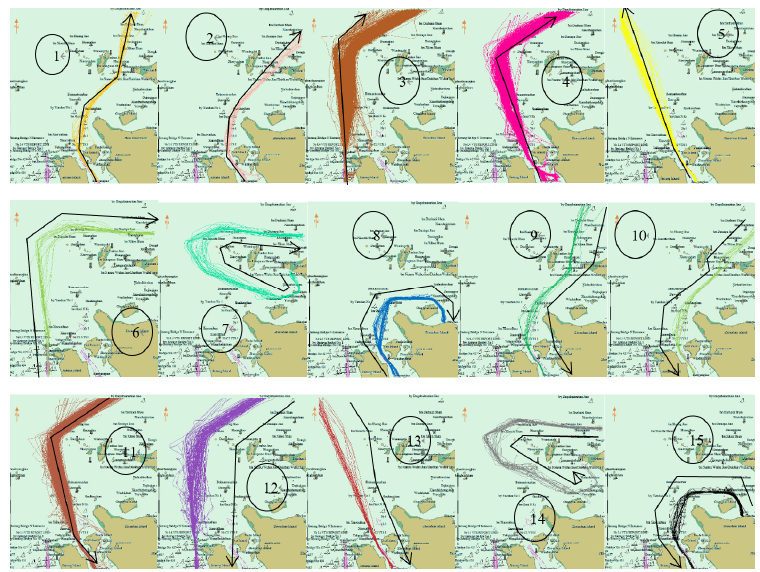
Figure 9. Clustering results before and after navigation prohibition. Different colors represent different clusters. After the construction of Yushan bridge, incremental clustering automatically makes the clusters across the bridge area disappear.